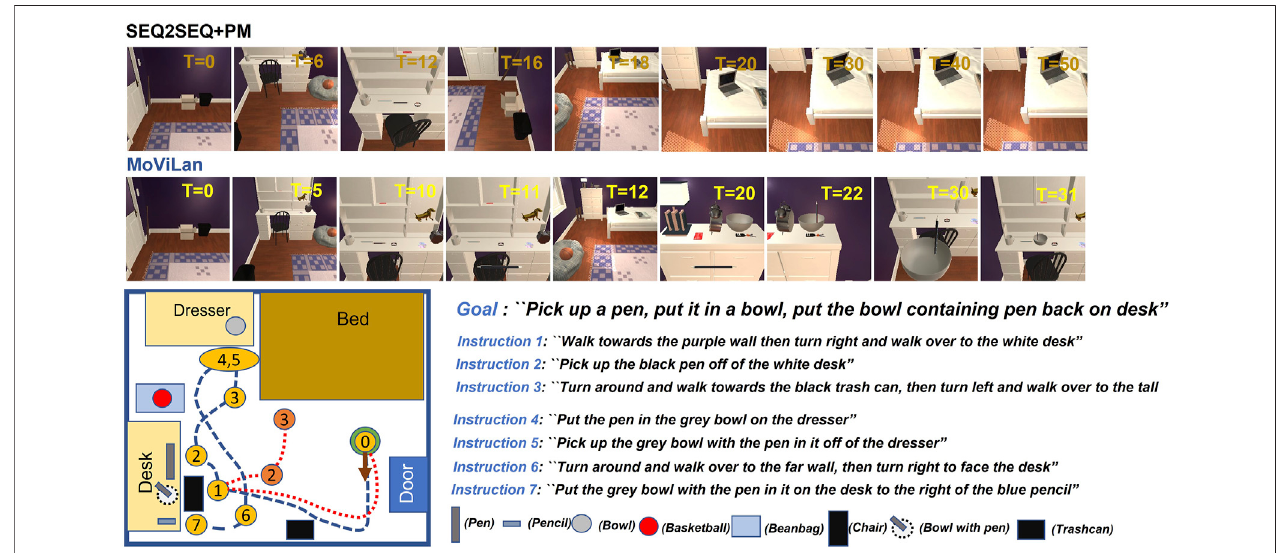
FIGURE 12 | Comparison of trajectories for the baseline and our methods; agent shown by green circle, with starting orientation shown by brown arrow; relevant subgoalscorrespondingtoinstructionsareshown inyellow (ours) andorange(author) coloredcircles;trajectoryforourmethod shown bydottedblue line(success) and that for baseline shown by dotted red line (failure).